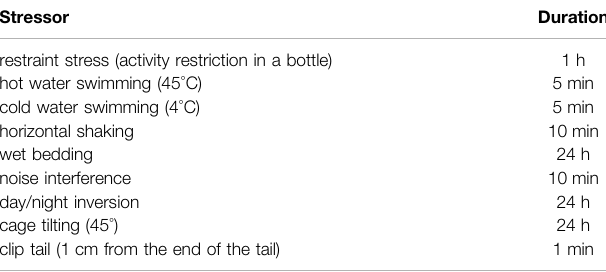
TABLE 1 | The stressor of CUMS procedure. Stressor Duration restraint stress (activity restriction in a bottle)